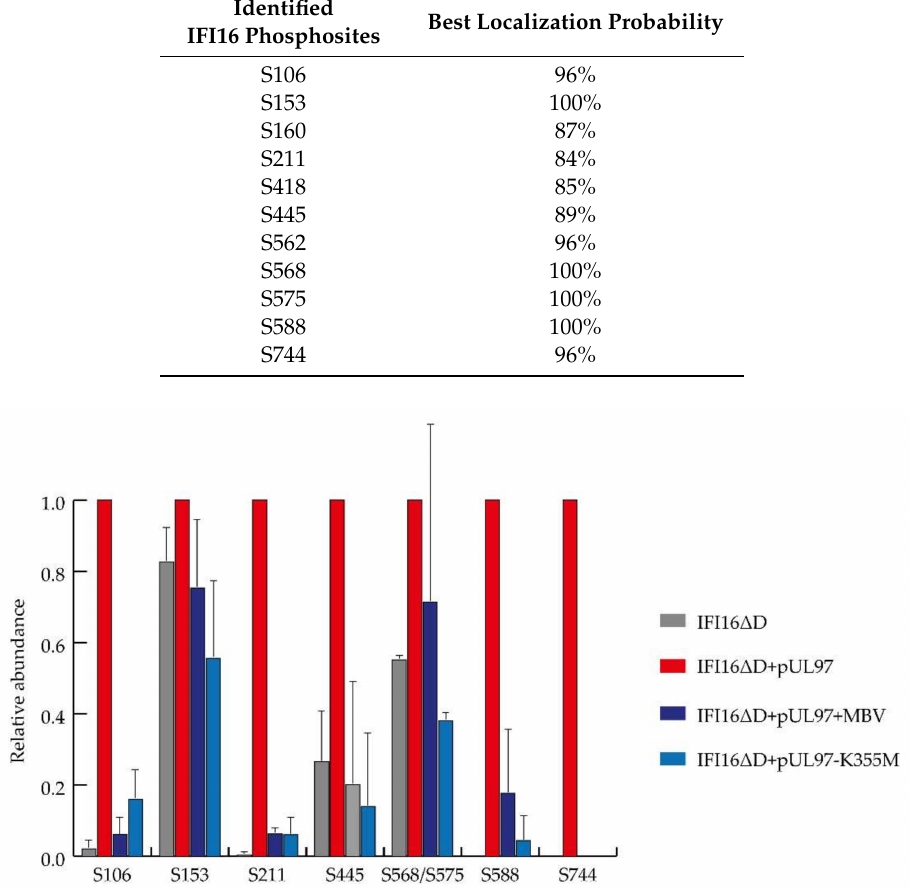
Figure 5. Dependence of IFI16 phosphosites on pUL97 kinase activity determined by mass spectrometry (MS)-based phosphoproteomic analysis. Extracted abundances of each phosphosite were normalized on the IFI16 ∆ D + pUL97 sample and averaged between the two independent replicates. Error bars represent standard